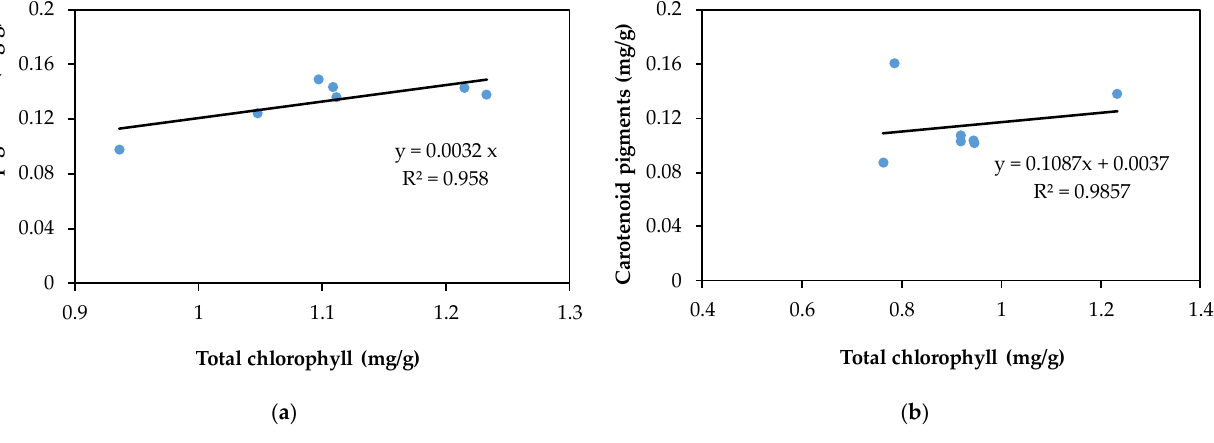
Figure 10. Relationship between total chlorophyll content and carotenoids in rapeseed leaves exposed to different concen- trations of lead ( a ) and cadmium ( b ).